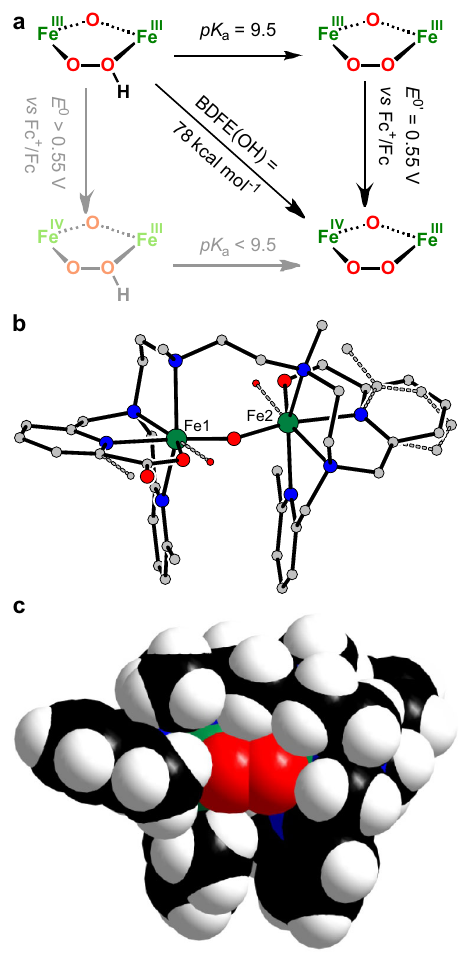
Fig. 7 Reactivity studies. a Square scheme showing the PCET thermochemistry of [(susan 6-Me ){Fe III ( μ -O)( μ -1,2-OOH)Fe III }] 3 + in CH 3 CN. b Molecular structure of the decay product of [(susan 6-Me ) {Fe III ( μ -O)( μ -1,2-O 2 )Fe III }] 2 + including the ligand disorders (please see also Supplementary Fig. 1c): at Fe1 80% carboxylate and 20% hydroxide (shown with dotted lines), at Fe2 35% benzylalcoholato and 65% hydroxide (shown with dotted lines). c Space- fi lling model of [(susan 6-Me ) {Fe III ( μ -O)( μ -1,2-O 2 )Fe III }] 2 + to illustrate the encapsulation of the peroxo ligand by a CH 2 group (right Fe) and a 6-methyl group (left